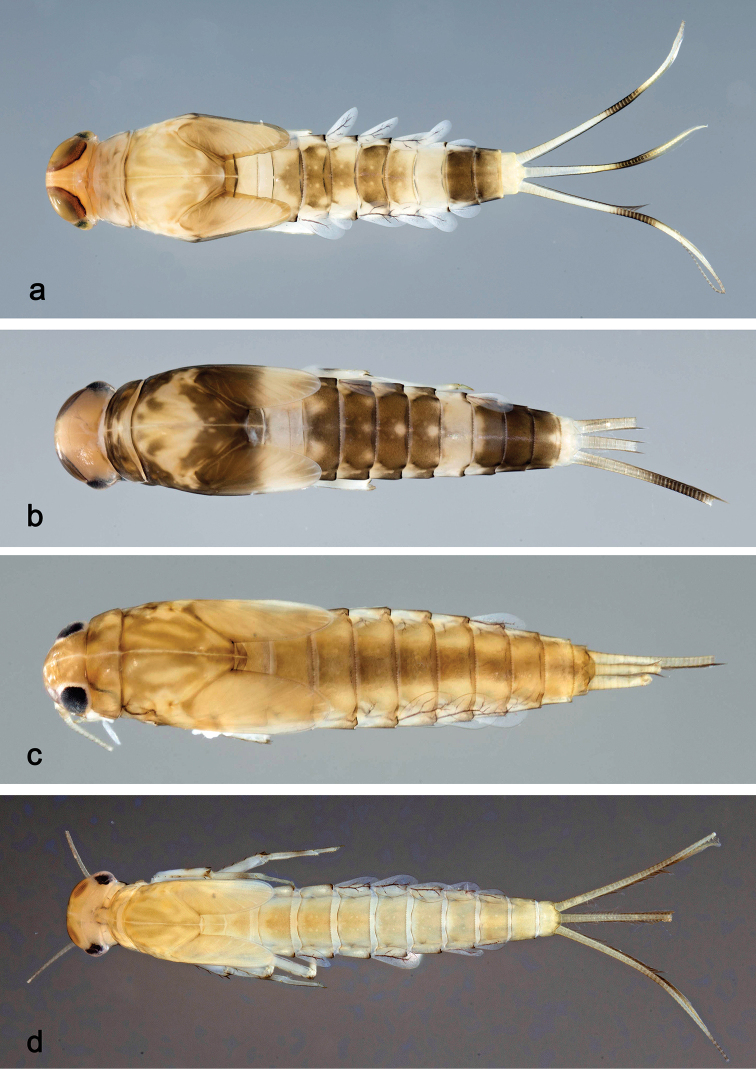
Habitus, larvae, dorsal view aLabiobaetis
valdezorum sp. nov. bLabiobaetis
wantzeni sp. nov. cLabiobaetis
baganii sp. nov. dLabiobaetis
delocadoi sp. nov.